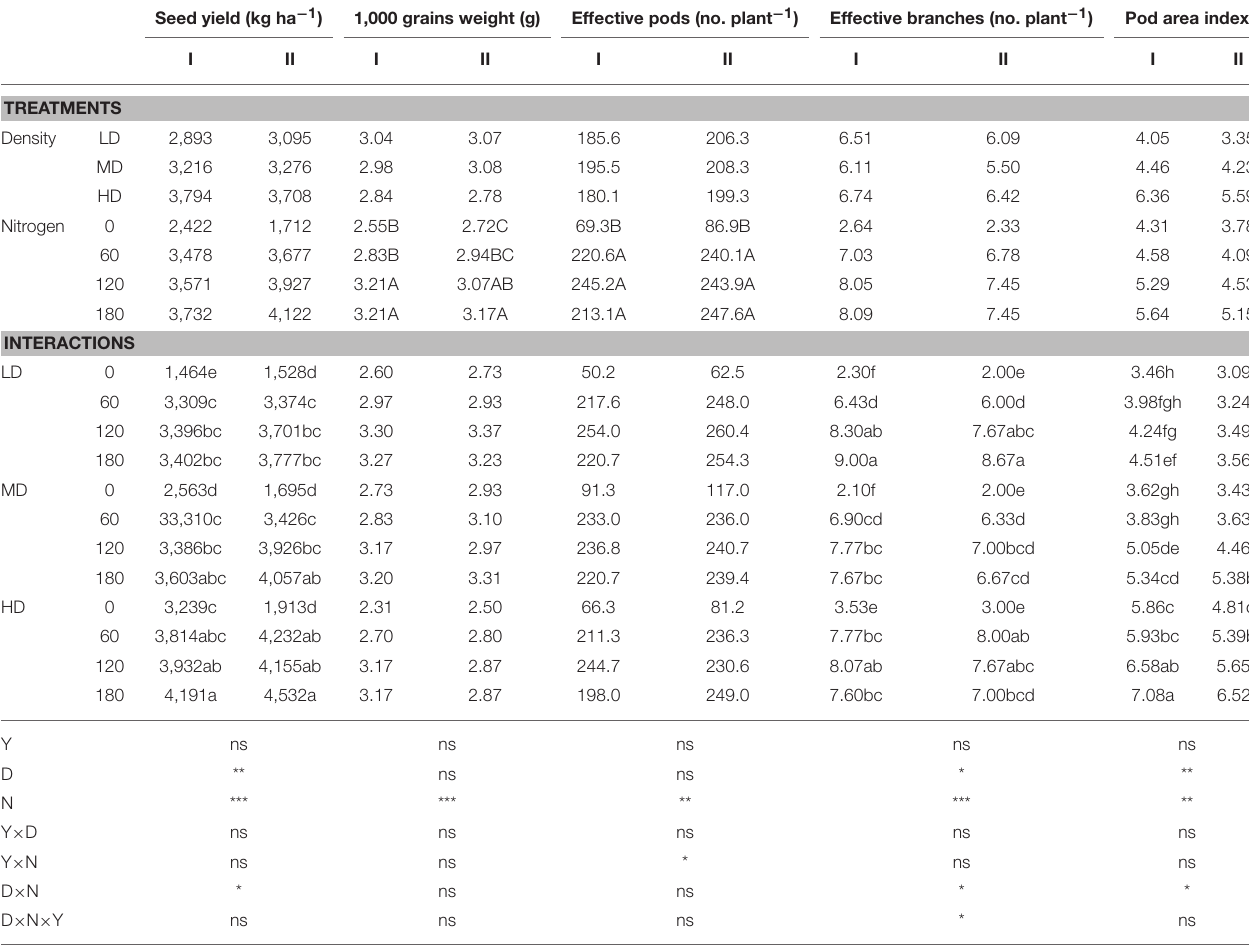
TABLE 3 | Effect of plant densities and N rates on seed yield, 1,000-seed weight, number of pods per plant, number of branches, and pod area index in the growing season of 2014/15 (I) and 2015/16 (II). Seed yield (kg ha − 1